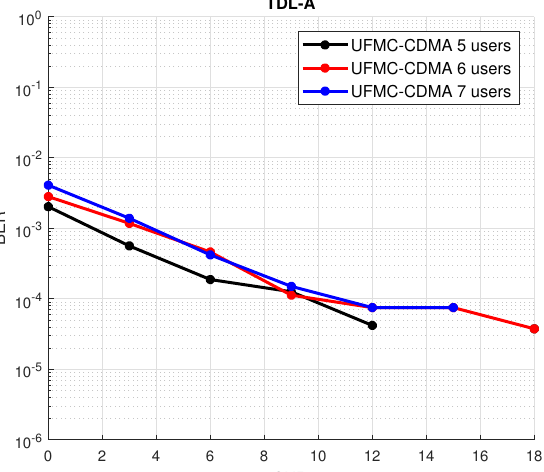
Figure 9. Uncoded BER of UFMC-CDMA under TDL-A channel and maximal Doppler shift f d = 100 Hz.